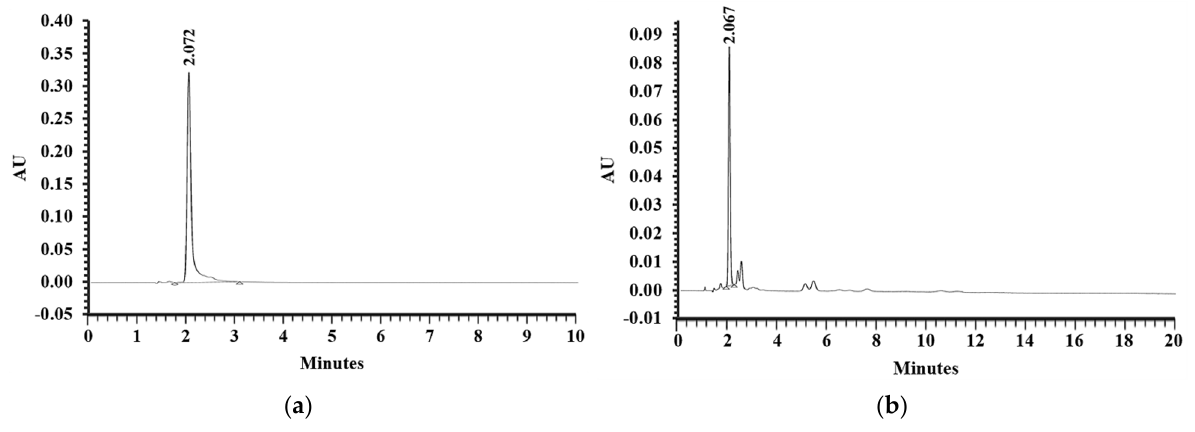
Figure 4. The chromatogram of ( a ) AST standard and ( b ) EESS.